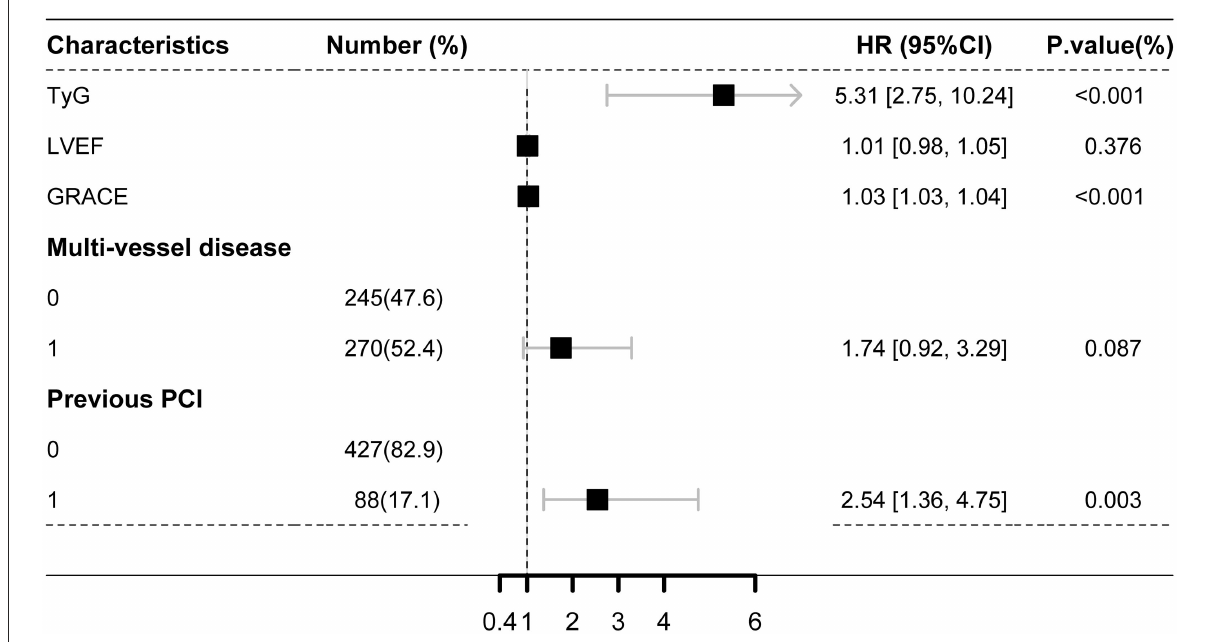
FIGURE2 Multivariate cox analysis for the predictors of the primary endpoint. GRACE score, Global Registry of Acute Coronary Events score; TyG index, triglyceride-glucose index; LVEF, left ventricular ejection fraction; HR, hazard ratio; CI, confidence interval.